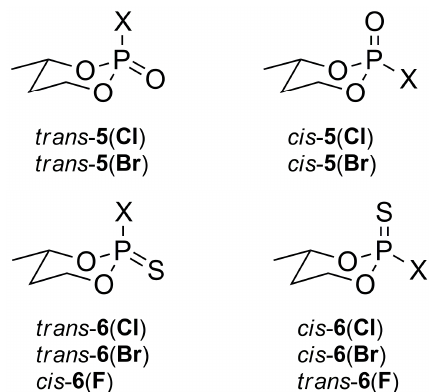
Figure 3. Structures of diastereomeric 2-halogeno-4-methyl-1,3,2-dioxaphosphorinan-2-ones ( 5 ) and 2-thiones ( 6 ) prepared and investigated by our group.